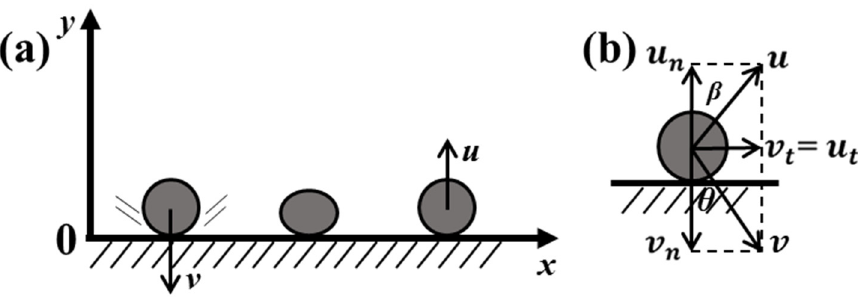
Figure 5. ( a ) First and second stages of particle impact on the surface of the coating, ( b ) oblique erosion of the coating by the particles.